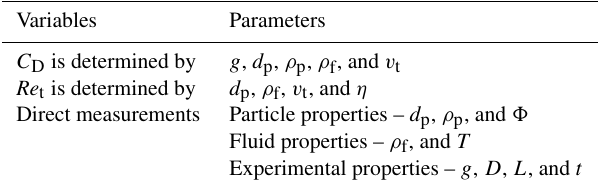
Table 4. Decisive variable and parameter